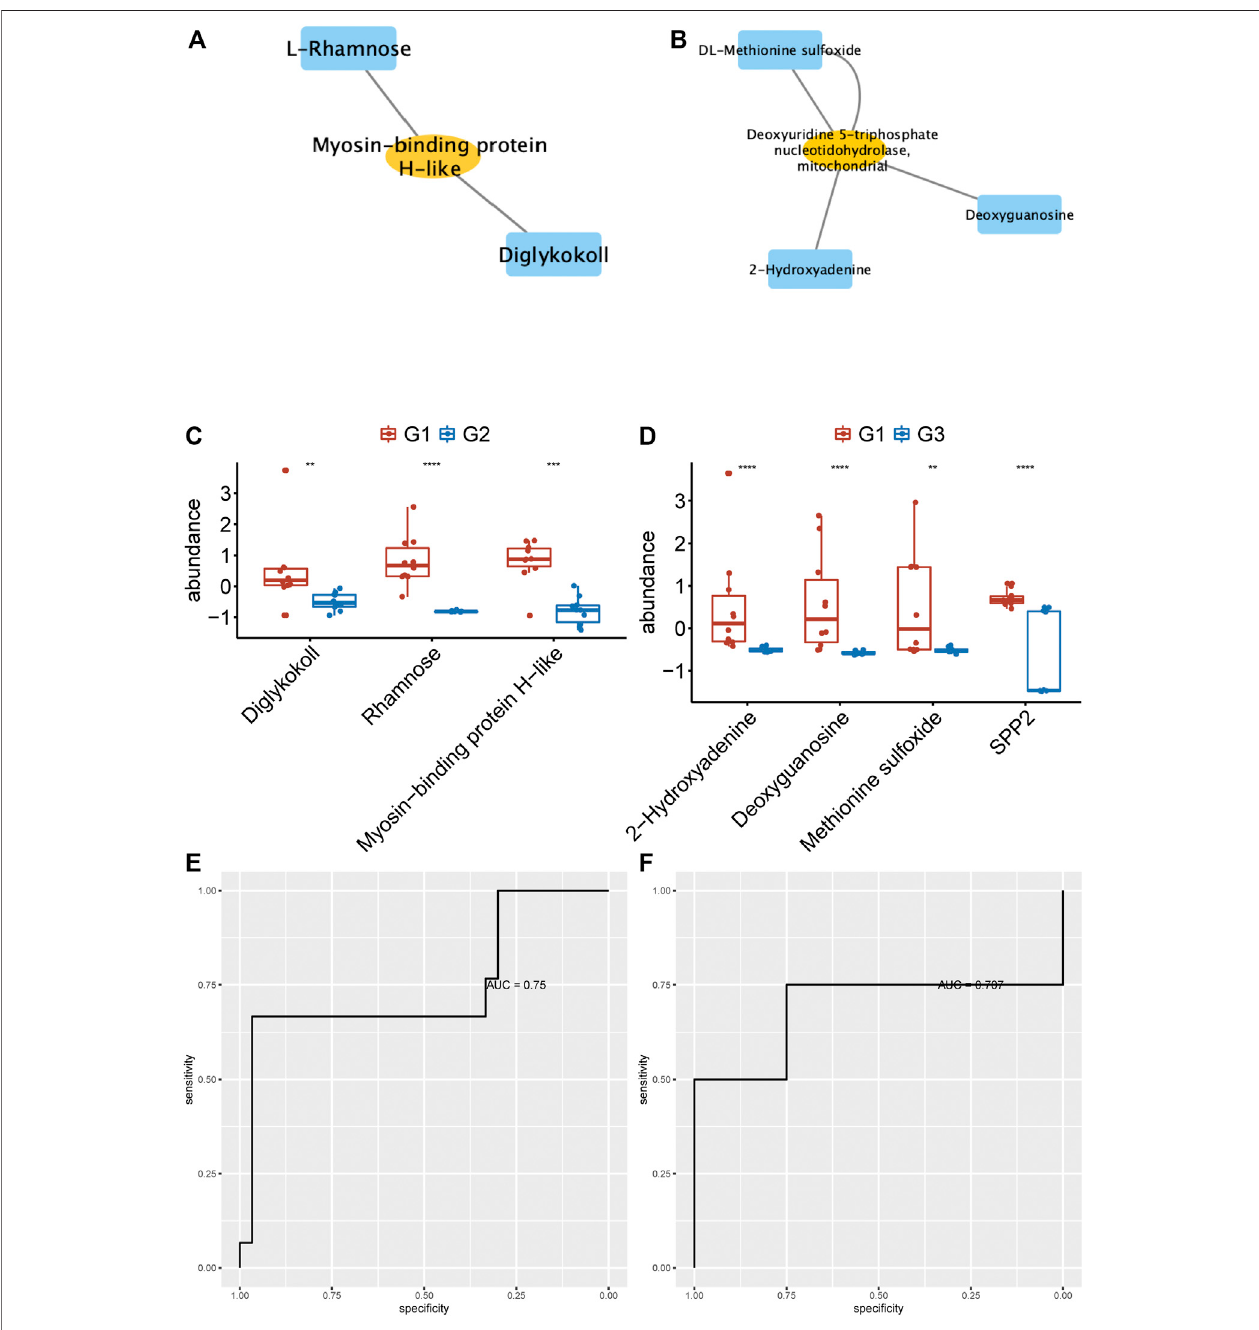
FIGURE6| Identi fi cationofhubnetworkstopredictvalvularAFandnon-valvularAF. (A,B) Weidenti fi edthehubnetworkinvalvularAF (A) andnon-valvularAF (B) . (C, D) Themetabolites and proteins ofhub networks were highly suppressed in valvular AF (C) and persistent non-valvular AF (D) . (E, F) Thehub networkcan effectively distinguish valvular AF (E) and non-valvular persistent AF (F) from SR